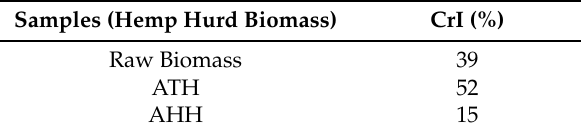
Table 3. Crystallinity index of hemp at different stages of extraction process of